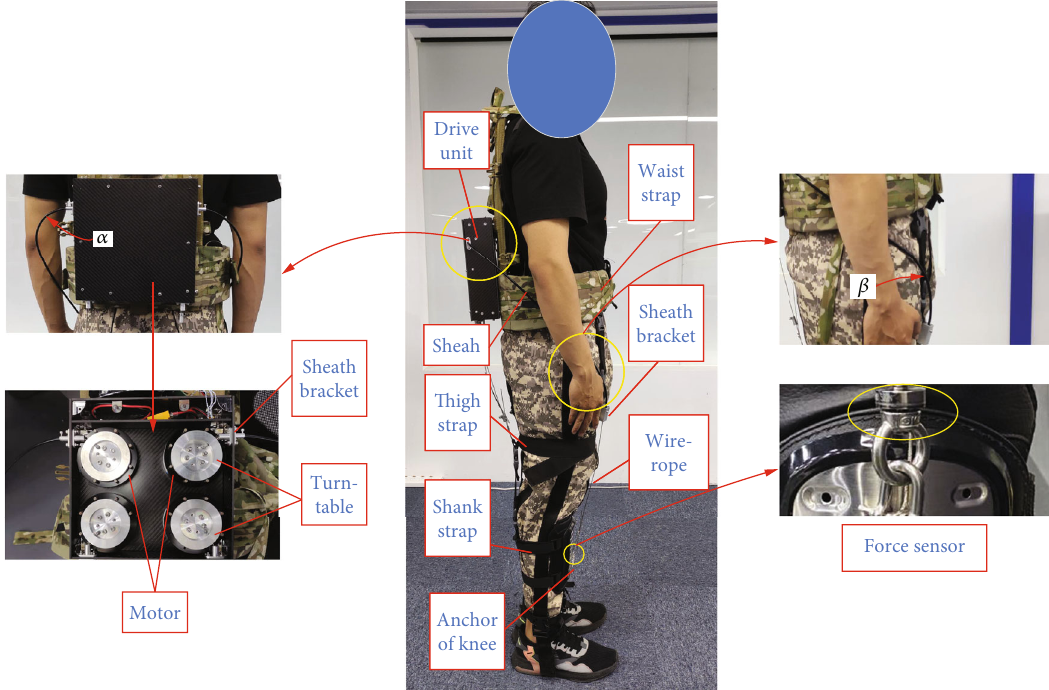
Figure 10: A fl exible exoskeleton for the experiment test.